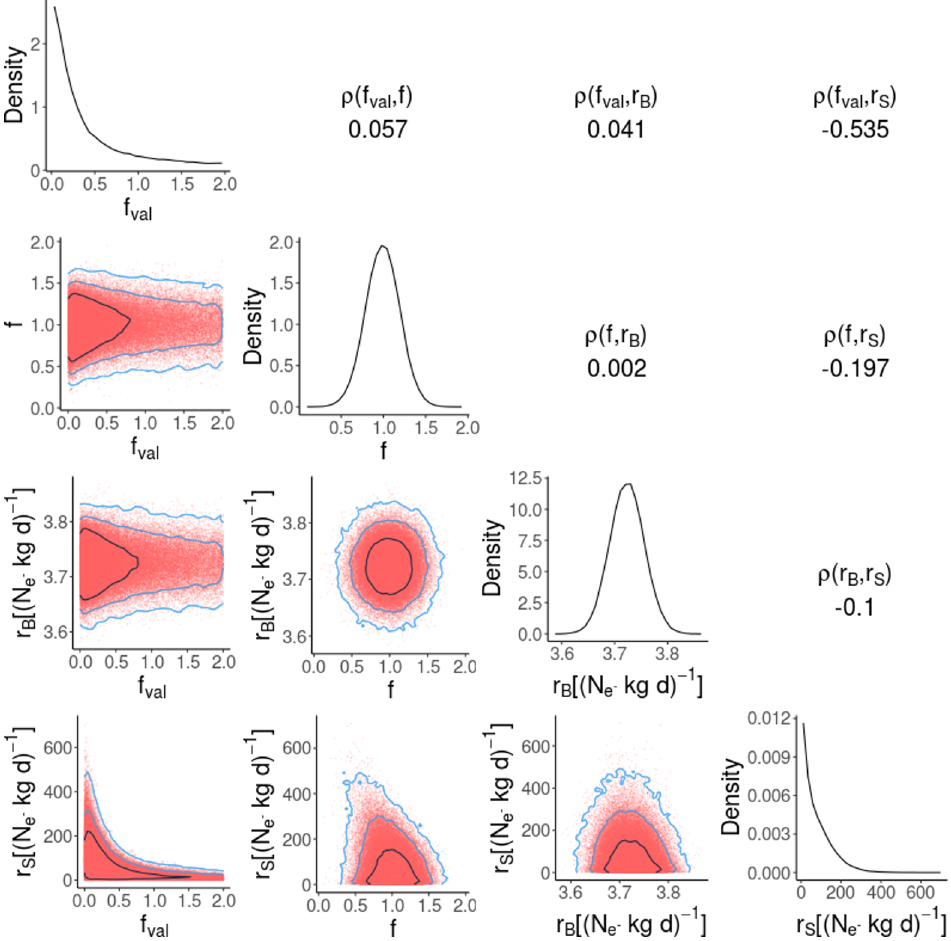
Figure 7 . Posterior p.d.f. for the relevant parameters of the likelihood using a Migdal-only signal with m (cid:31) = 130 MeV =c 2 and a simulated dataset based on the background-only template, without the LowNe excess. The 4 plots on the diagonal of the figure are the uni-dimensional p.d.f. of each single parameter obtained by marginalising on all the others. The 6 bi-dimensional p.d.f. in the bottom-left corner of the figure give the joint p.d.f. of each pair of parameters obtained by marginalising on the others. The plots show also the credible regions at 68% ; 95% ; 99 : 7% probability as solid contour lines. The correlation coefficients are given in the upper-right corner of the